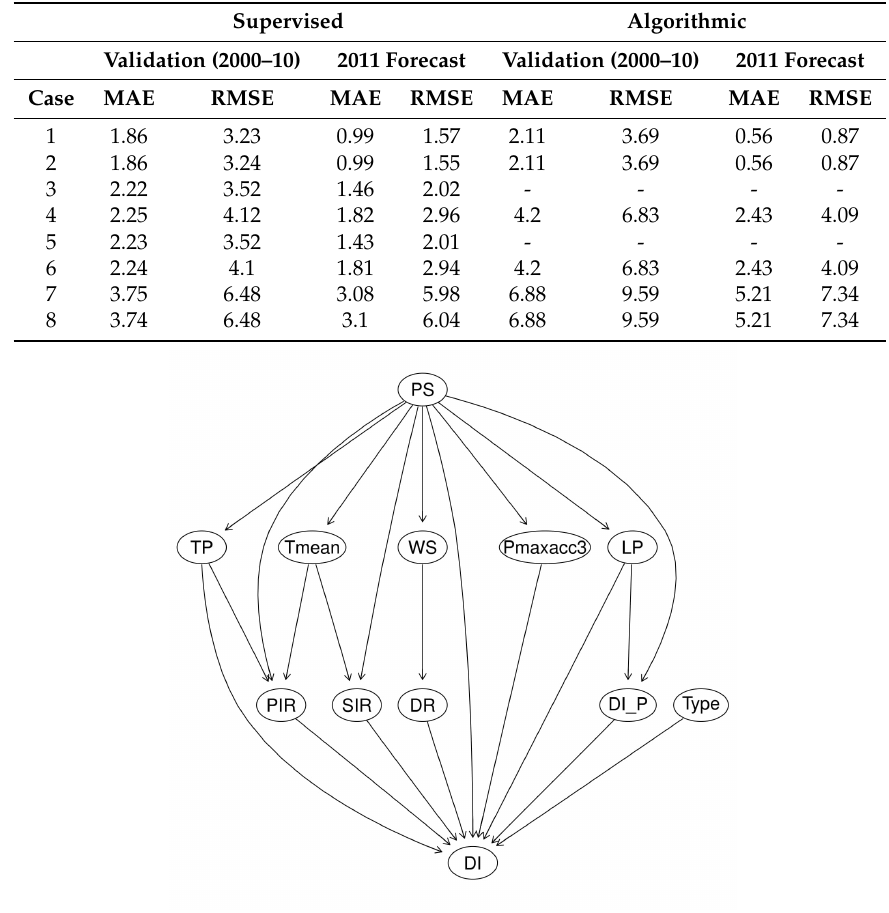
Figure 6. Directed acyclic graphical (DAG) representation of Bayesian network model structure identified by supervised learning of grape PM. The causal relationships between the variable were linked by existing empirical and published scientific peer-reviewed knowledge on the interactions between the climate, host, and pathogen. Variables in the DAG representation includes: plant stage (PS), total precipitation (TP), daily mean temperature (Tmean), wind speed (WS), degree-days based risk assessment model P maxacc3 (3 ◦ C), latent period (LP), primary infection rate (PIR), secondary infection rate (SIR), dispersal rate (DR), recent disease incidence ( DI P ), cultivar (Type), and disease incidence